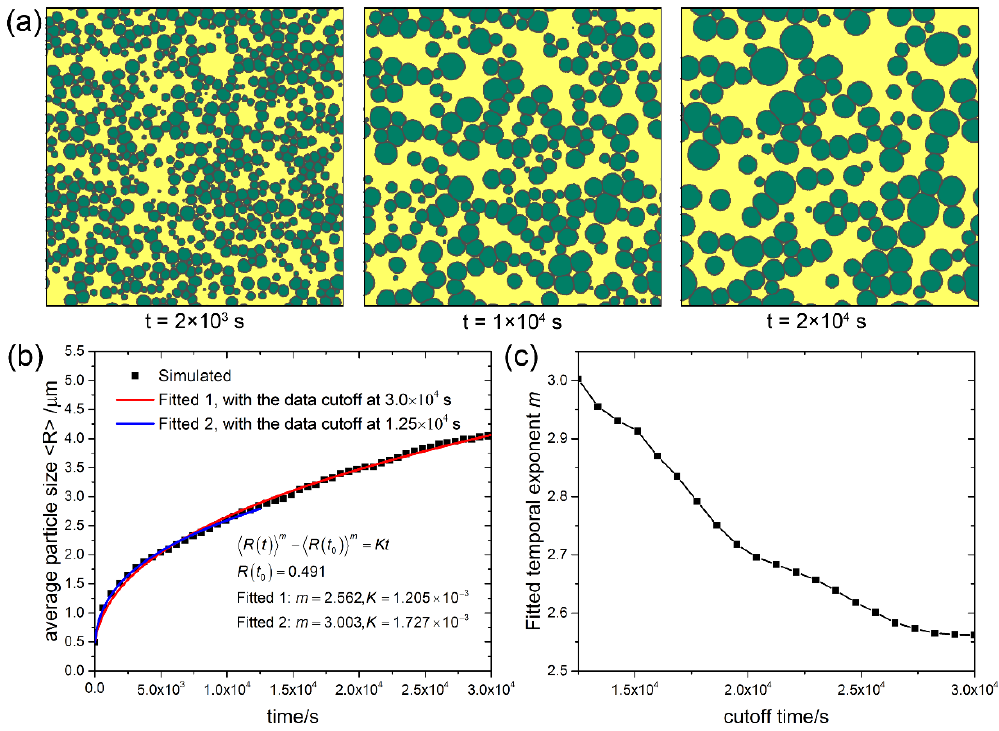
Figure 3. System with f v = 50%. ( a ) Microstructure evolution; ( b ) Average particle size vs. time; ( c ) Fitted temporal exponents m of the power law (cid:104) R ( t ) (cid:105) m − (cid:104) R ( t 0 ) (cid:105) m = Kt at different cutoff times. Simulation grid is 1000 × 1000 with the cell size of 0.1 μm.